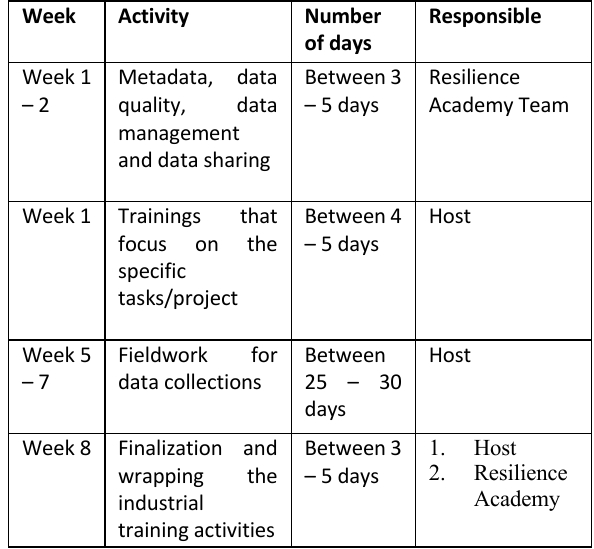
Table 1: Approximate time from which each activity takes during the industrial training